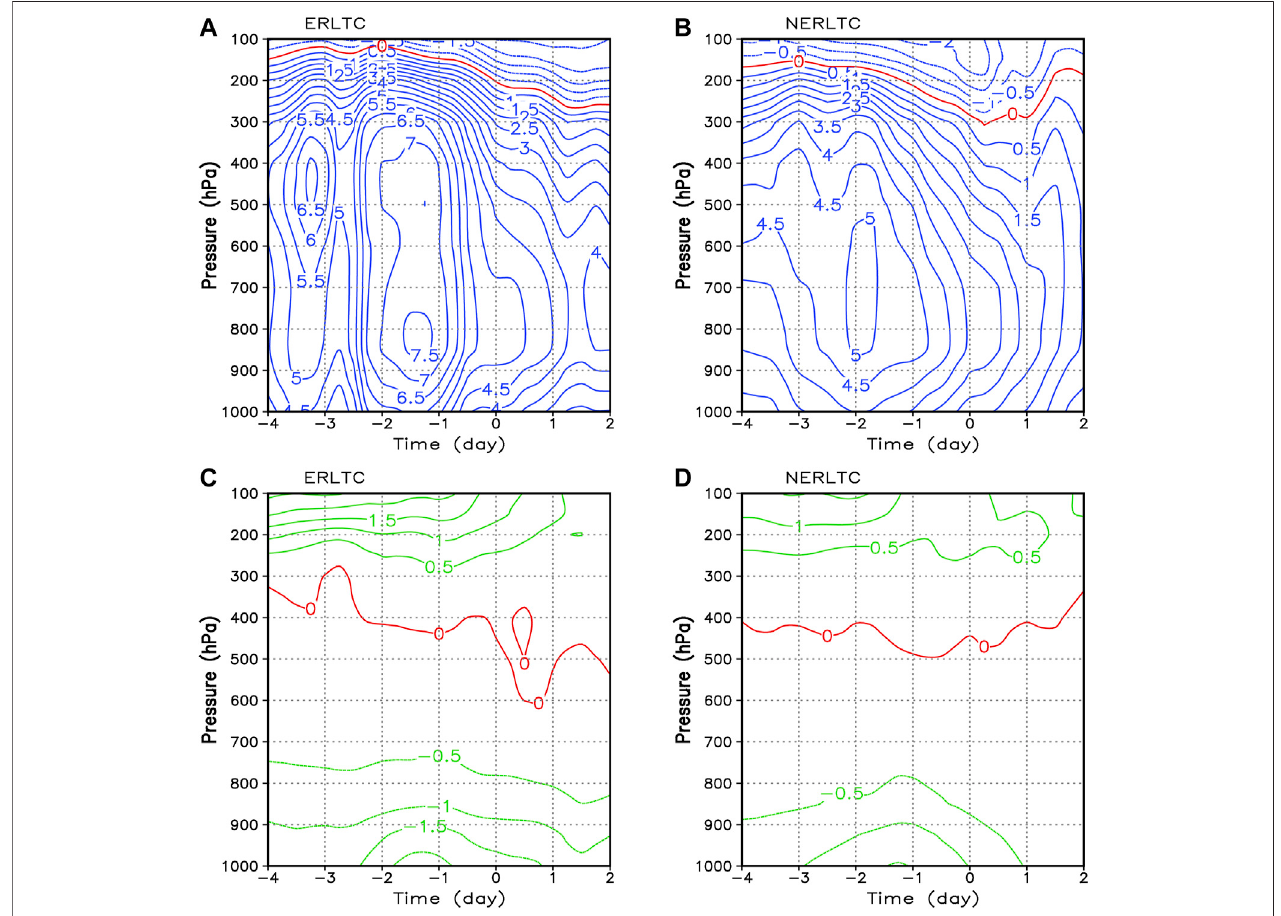
FIGURE5| Height – timeevolutionofthe (A,B) relativevorticity(units:10 – 5 s − 1 )and (C,D) divergence(units:10 – 5 s − 1 )for (A,C) ERLTCsand (B,D) NERLTCsacross the typhoon